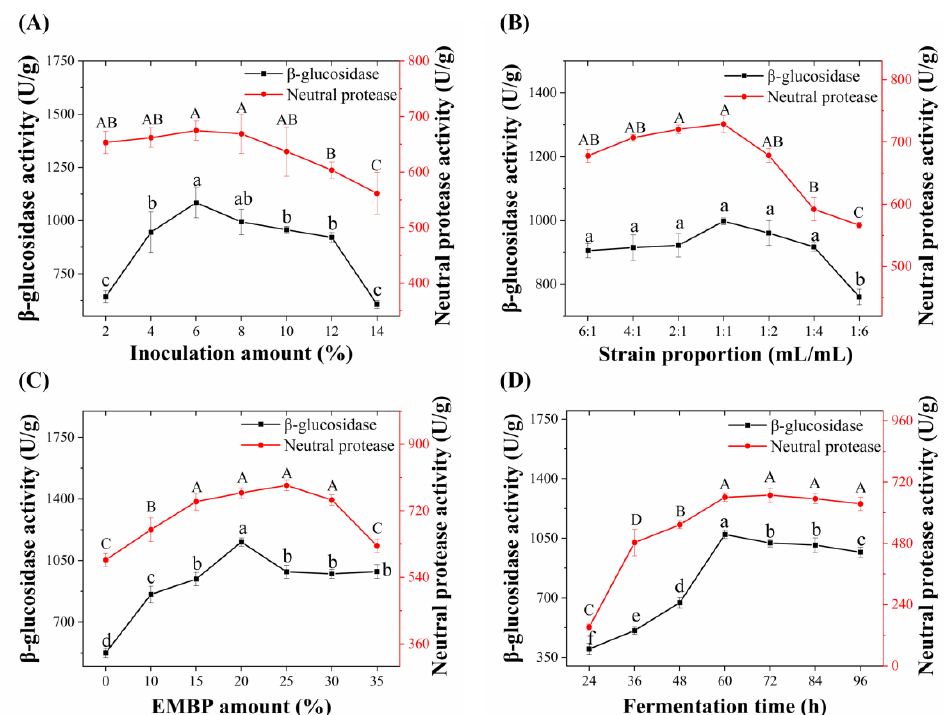
Figure 2. Effects of different inoculation amount ( A ); strain proportion ( B ); EMBP amount ( C ) and fermentation time ( D ) on the activities of neutral protease and β -glucosidase in EMDK. Values are expressed as the mean ± the SD (n = 3). Bars with different uppercase or lowercase letters represent significant differences ( p < 0.05).